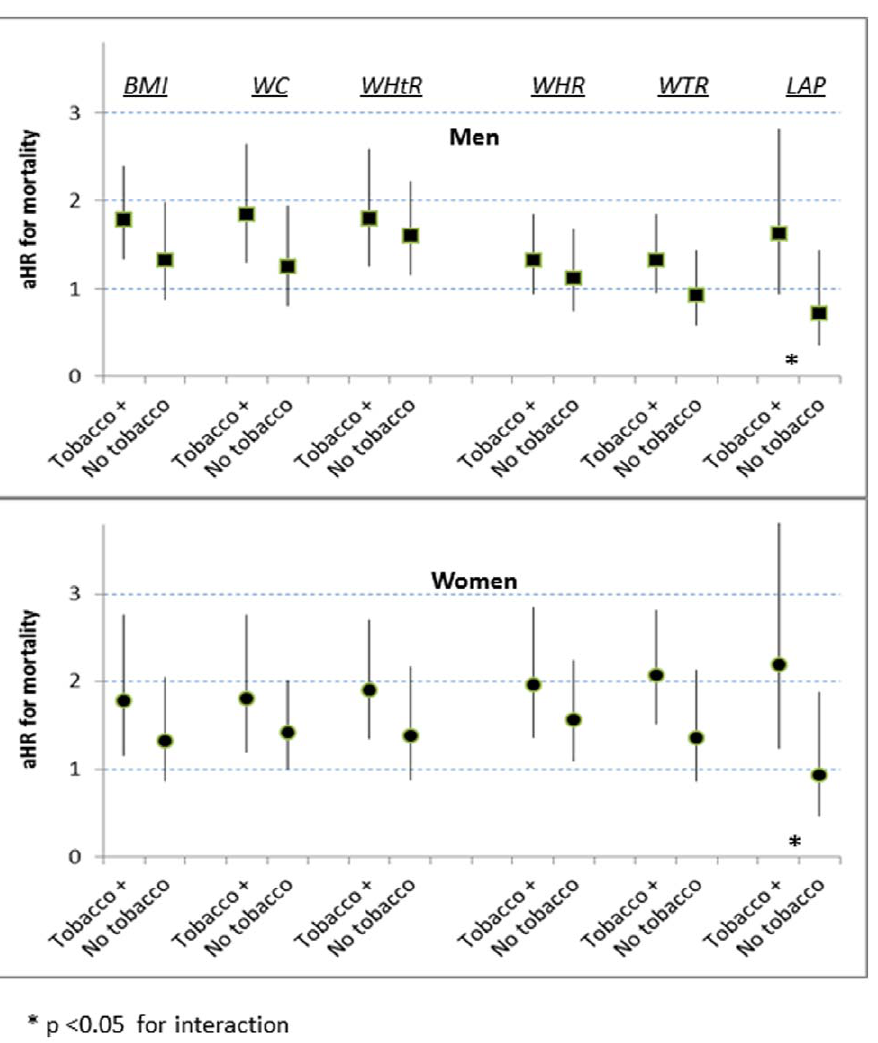
Figure 4. Interactions with tobacco exposure for mortality risk at p75, by 6 adiposity indicators. (aHR multiply adjusted hazard ratio).